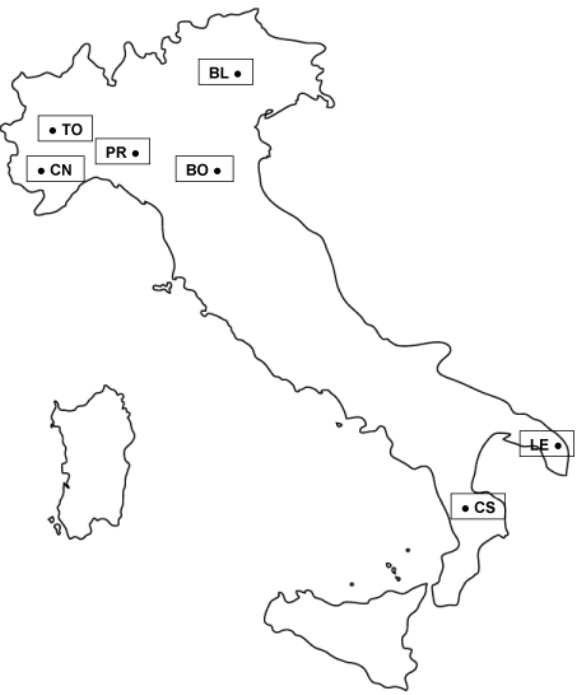
Figure 1. Map of the Phytophthora infestans isolate collec- tion sites in Italy. Letters correspond to respective isolate designations (Table 1).